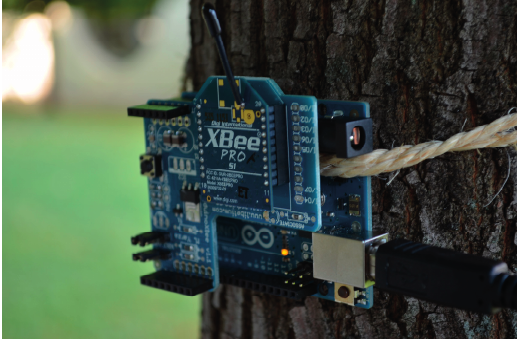
Figure 16. The ZigBee mote used for wireless communications in the vegetation environment.